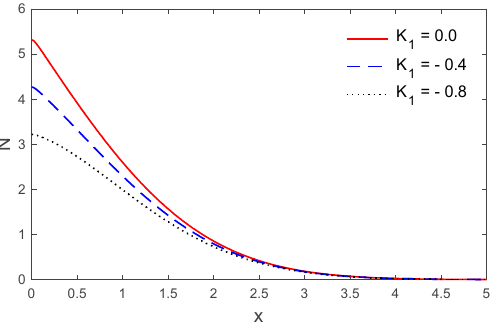
Figure 2. Variations of heat conduction with respect to the distance for various values of K 1 .